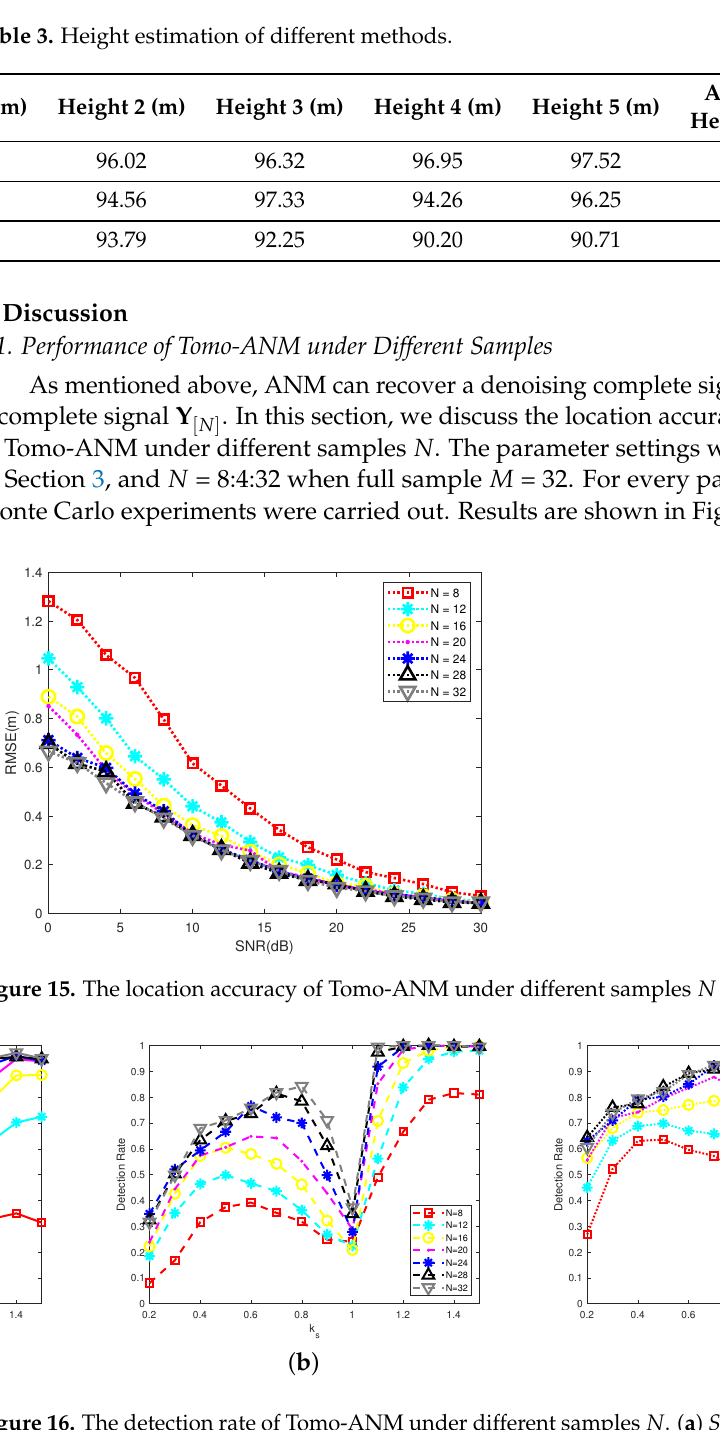
Figure 16. The detection rate of Tomo-ANM under different samples N . ( a ) SNR = 10 dB. ( b ) SNR = 20 dB. ( c ) SNR = 30